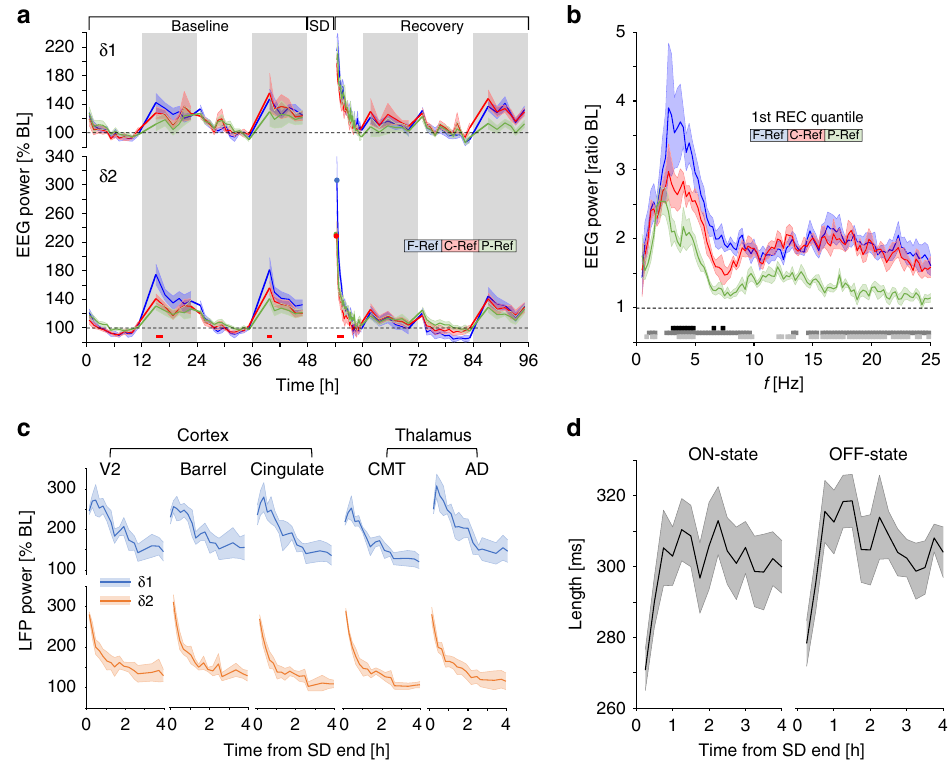
Fig. 4 δ 2-dynamics are visible throughout the thalamus and cortex. a Time-course of δ 1- (upper) and δ 2-power (lower graph) at different cortical surface sites. δ 2 is high at speci fi c times during baseline (dark period) and following SD, and was highest in frontal areas, whilst derivation did not affect δ 1 ( δ 2: 2- way rANOVA factors site × frequency bin: F 168,1008 = 1.7, p = 1.0E-6). Circles denote initial values following SD for δ 2 to emphasize frontal dominance in rebound. Red squares denote post-hoc signi fi cance between F-Ref and C-Ref/P-Ref. b EEG spectra differed across recording site during initial recovery NREMS (two-way rANOVA factors site × frequency bin: F 196,1470 = 1.44, p = 2.0E-4). Black, dark gray, and light gray lines in lower panel represent post- hoc signi fi cant differences ( p < 0.05; Tukey) between F – C, F – P, and C – P, respectively ( n = 6). c LFP recordings following 4 h SD in multiple brain